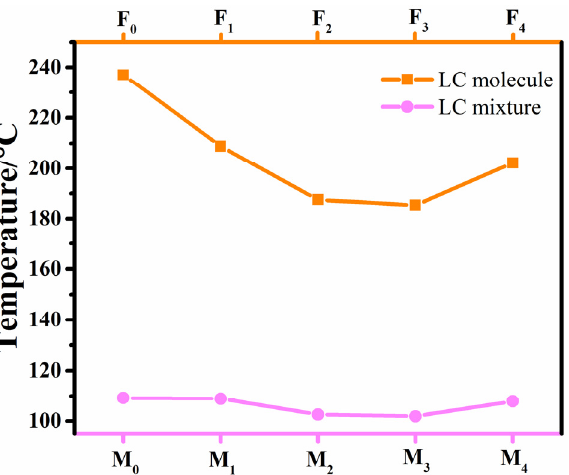
Figure 3. The clearing points of benzoxazole LC compounds and their corresponding LC mixtures.